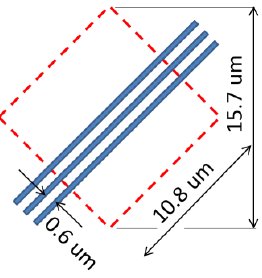
Figure 10. Pixel size and metal wiring direction and pitch.